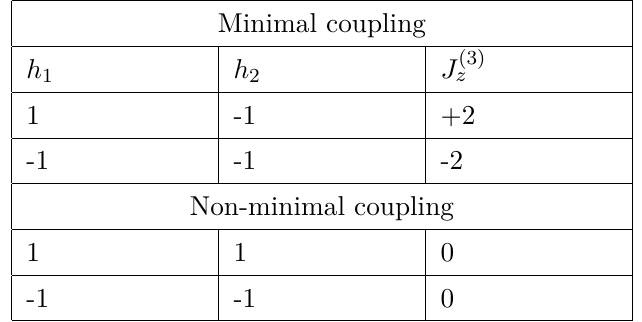
Table 1 . Helicity decomposition of photon-photon-massive spin J three point function. where h = h − h and h 0 = h − h . m and J are the mass and the spin the of the 1 2 3 4 J exchange particle. d ( J ) ( θ ) is the Wigner little- d matrix (see C.4 for a review). f N hh 0 given